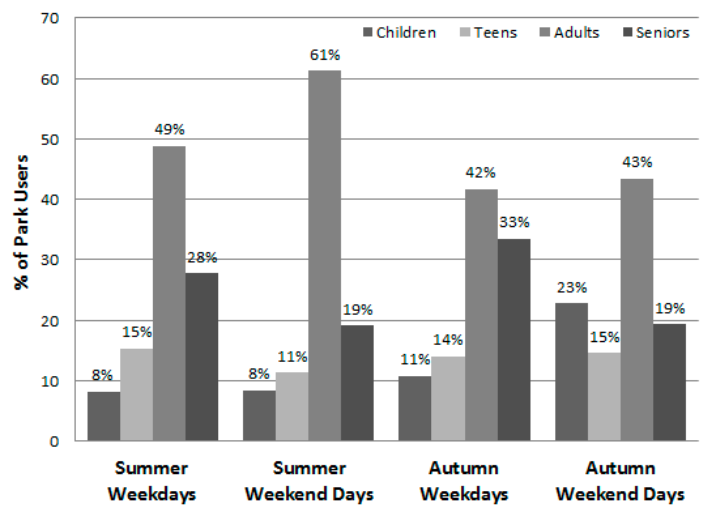
Figure 4. Percent of park users by season on weekdays and weekend days by age group ( n = 28,585).